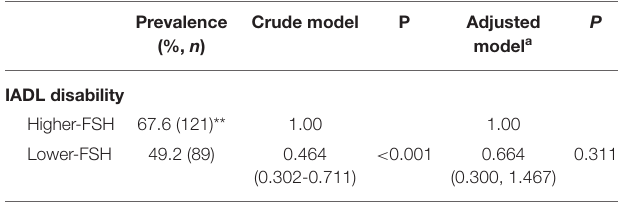
TABLE 4 | Multivariate-adjusted logistic regression analyses of associations between follicle-stimulating hormone (FSH) levels and IADL disability. Prevalence Crude model P Adjusted (%, n ) model